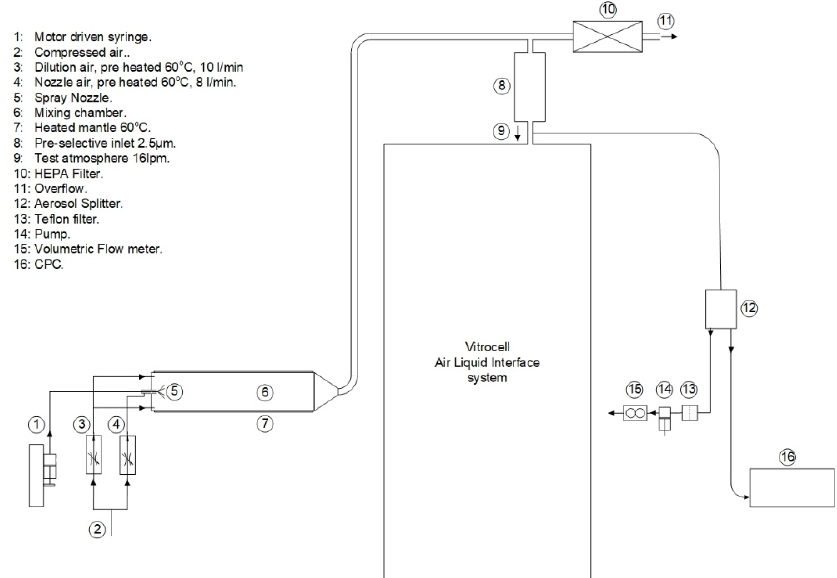
Figure 1. Aerosol generation set-up. Engineered nanoparticles (ENP) aerosols were generated by controlled injection of the ENP aqueous suspensions by means of a syringe pump to a spray nozzle were the liquid was nebulised using pre-heated compressed air. This aerosol was further dried and mixed in a nebulising cylinder connected to the Vitrocell ® automated exposure station (AES). Just before entering the AES, a Teflon filter and a condensation particle counter (CPC) were connected for aerosol characterisation.